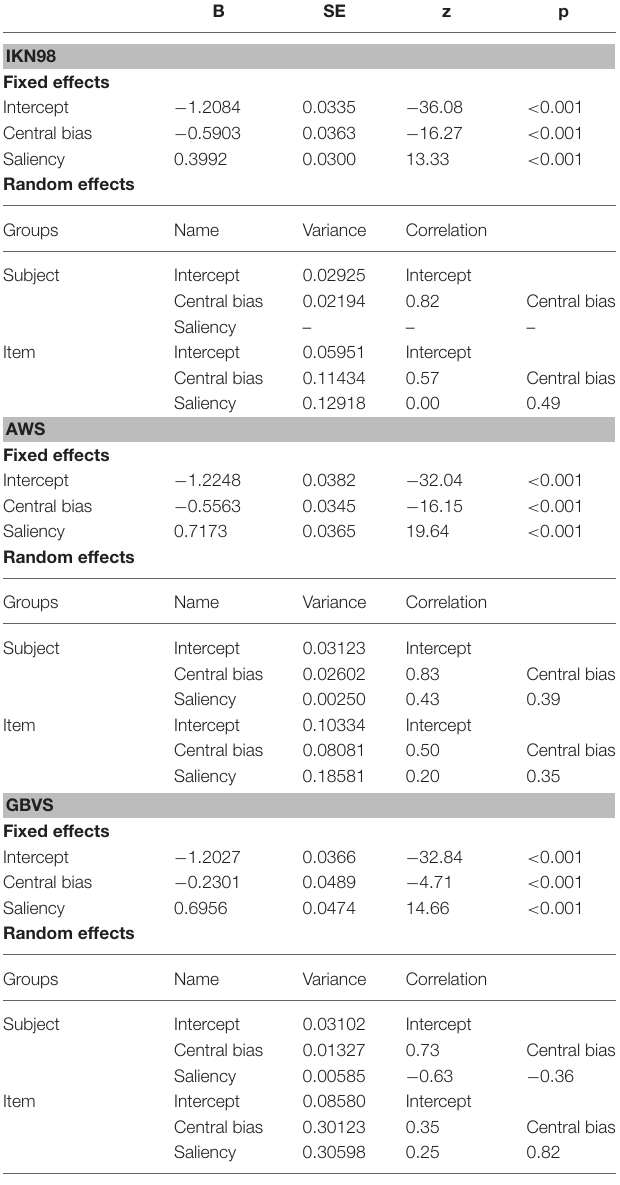
TABLE 3 | Three Central-Bias—Saliency GLMMs fitting fixation probability for a scene memorization